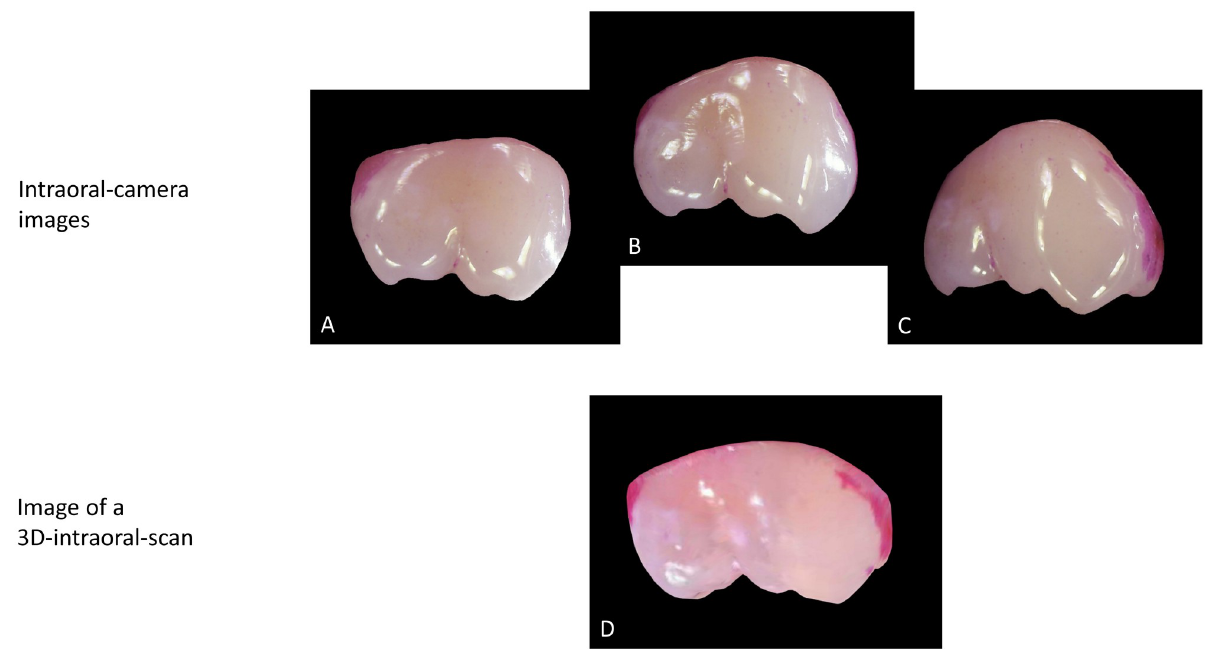
Fig 6. The difference between an intraoral-camera image and the image of a 3D-intraoral-scan of tooth 16 is shown here. While in the intraoral- camera image the proximal surfaces remain hidden in the central image due to the convexity of the tooth, the tooth appears flattened on the image of the 3D-intraoral-scan and the proximal surfaces are more visible. A-C: Intraoral-camera images: A: mesial view, B: central view, C: distal view. D: an image from the 3D-intraoral-scan with a central